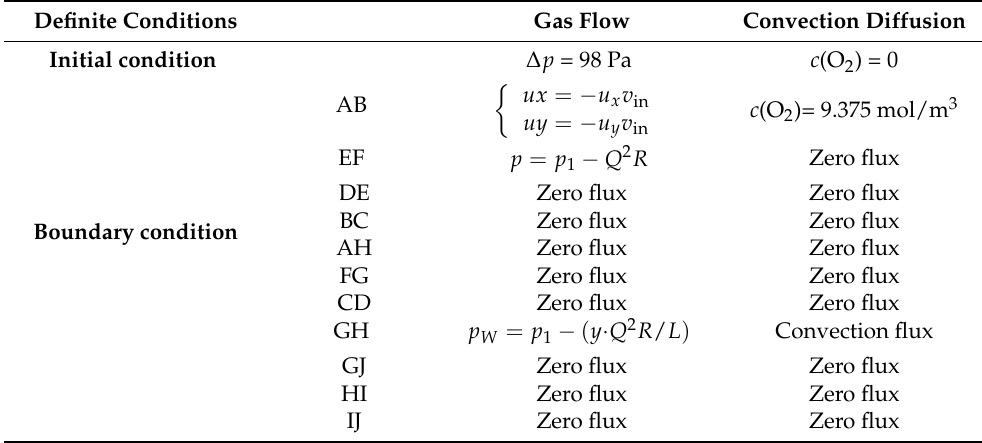
Table 2. The imposed boundary conditions and initial values.